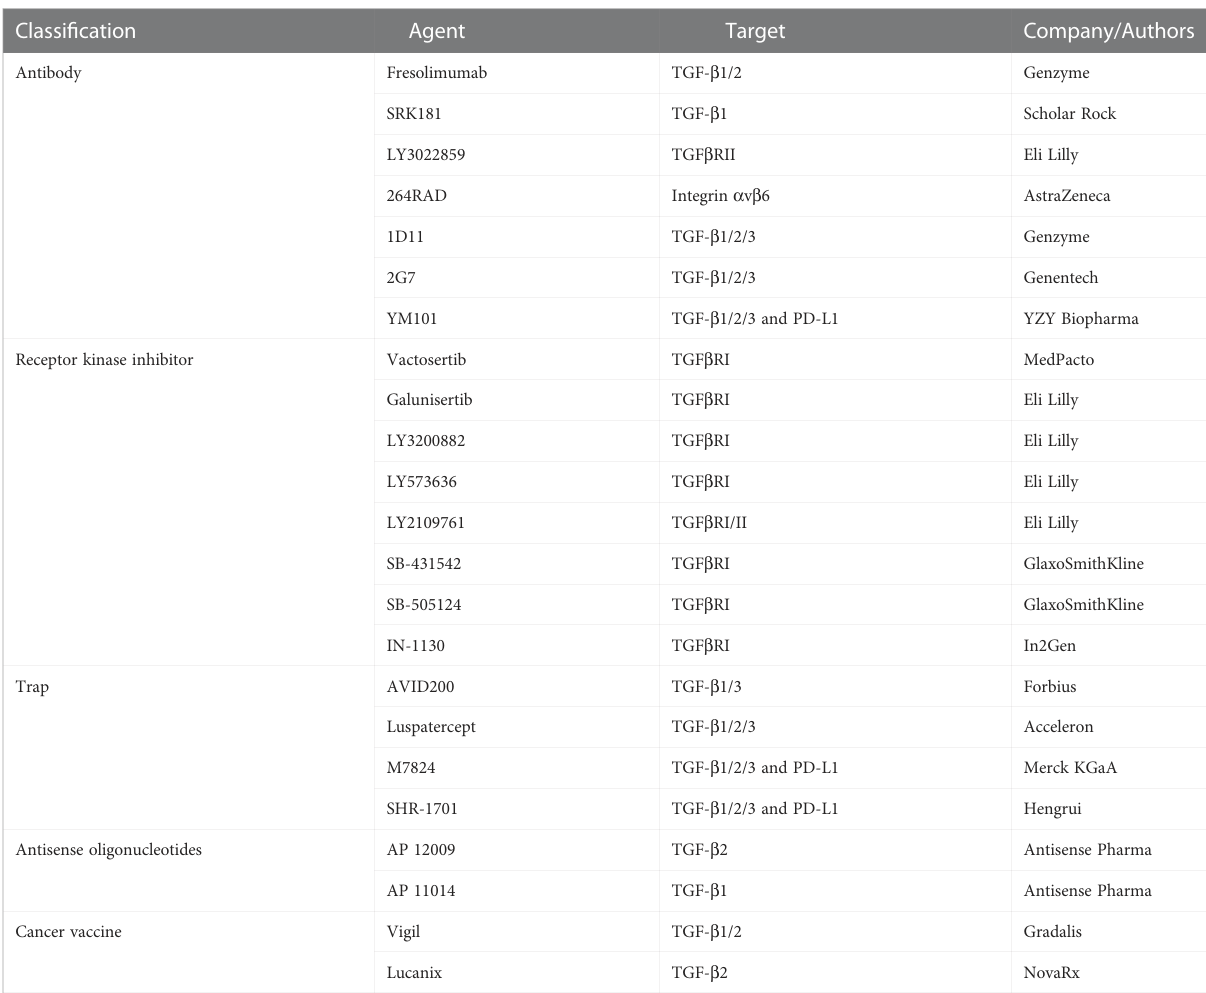
TABLE 1 Agents targeting TGF- b signaling pathway.